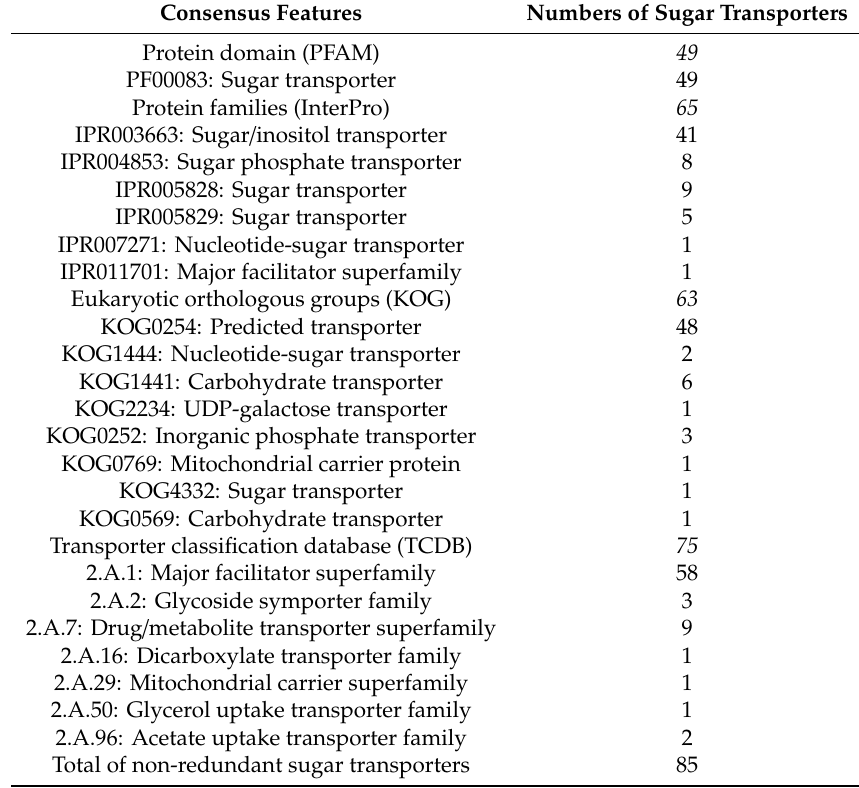
Table 1. Characteristics and consensus features of sugar transportome in C. militaris